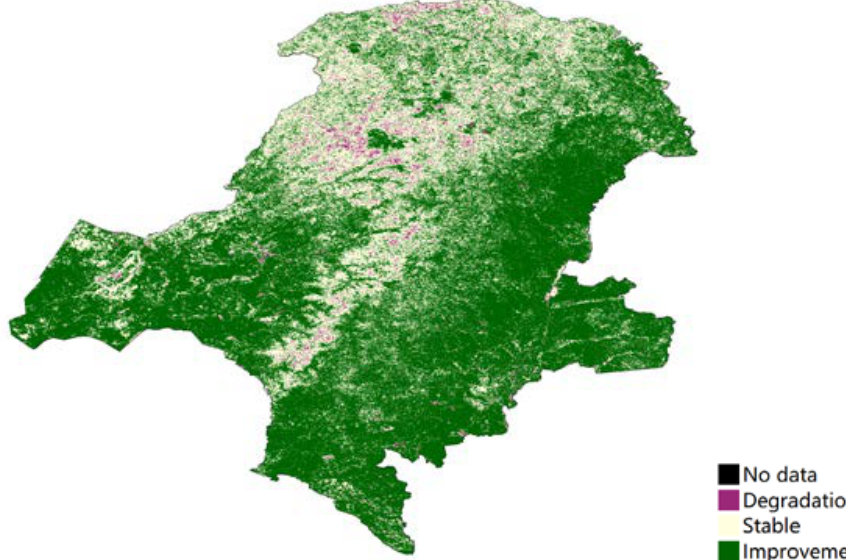
Figure 8. Productivity state degradation in Great Khingan Mountain (GKM), China (2001–2010 vs. 2011–2018).